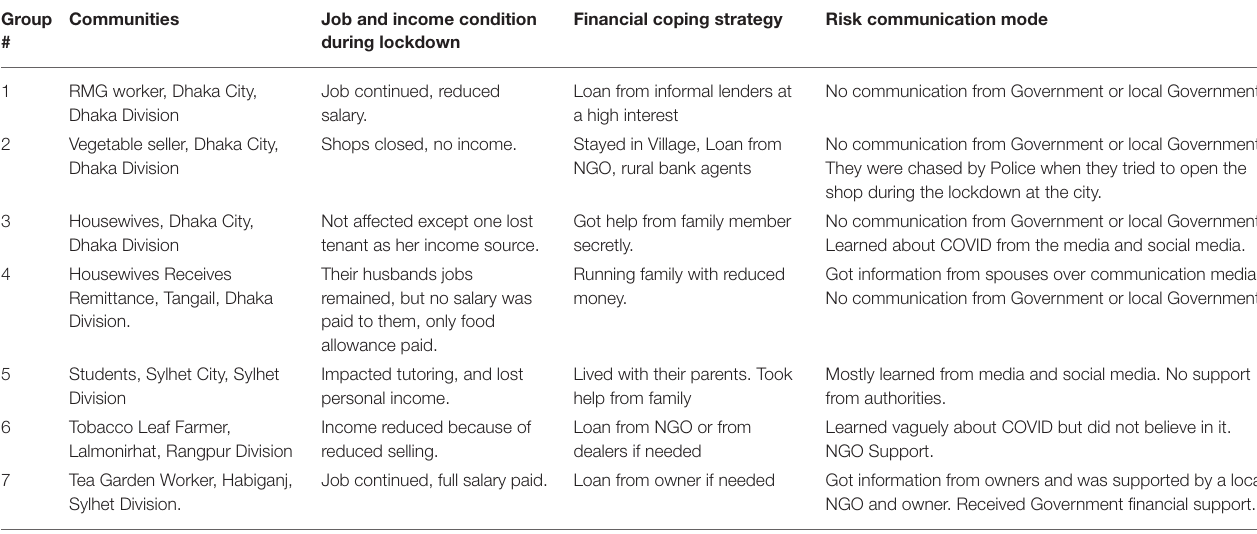
TABLE 2 | Work-related and financial impact during COVID-19 pandemic. Group #